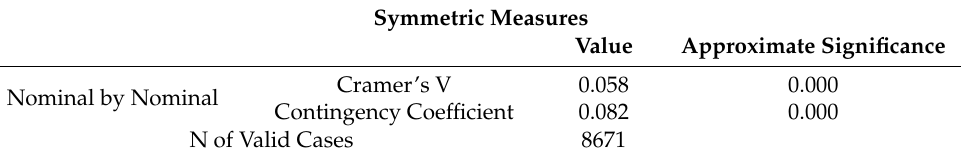
Table 14. Strength of dependence between variables. Source: own